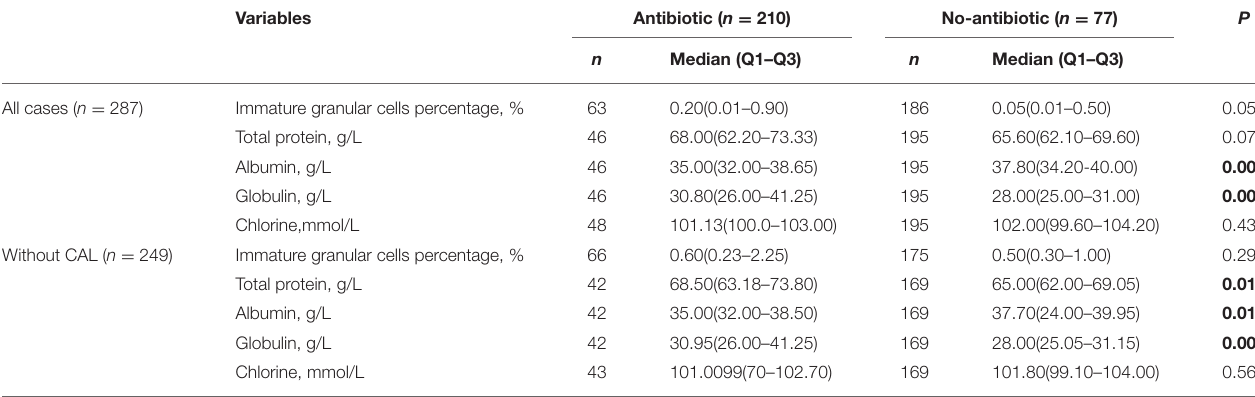
TABLE 4 | Comparison of groups with antibiotic and